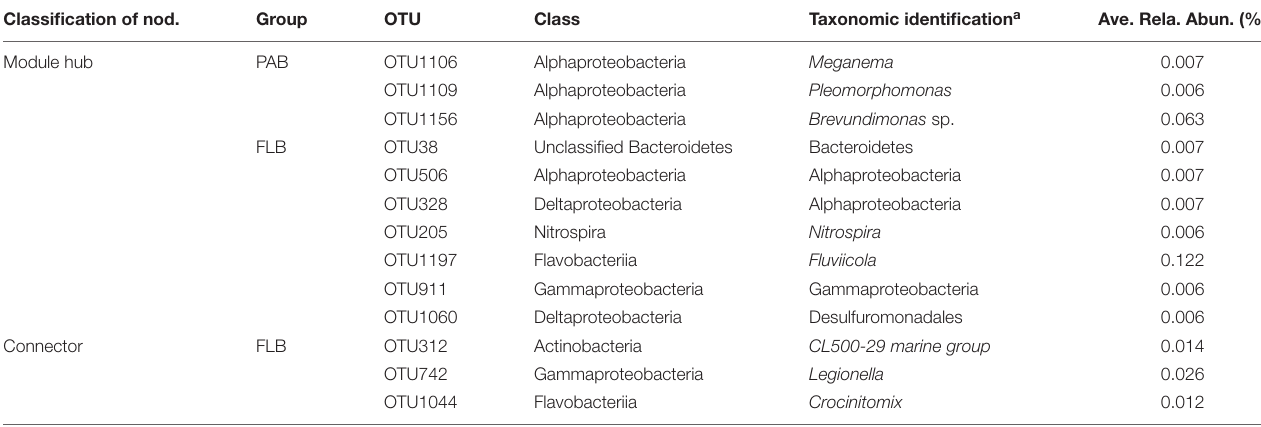
TABLE 4 | Classification and relative abundance of module hub and connector nodes in PAB and FLB networks. Classification of nod.